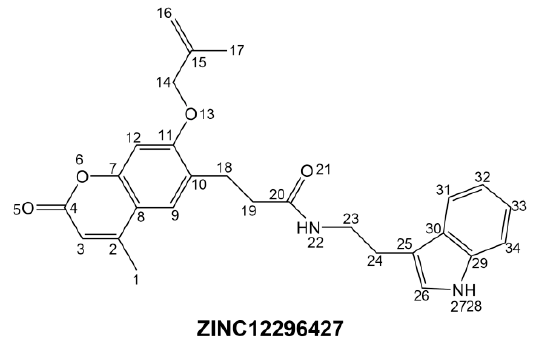
Figure 1. Cont. Figure 1.